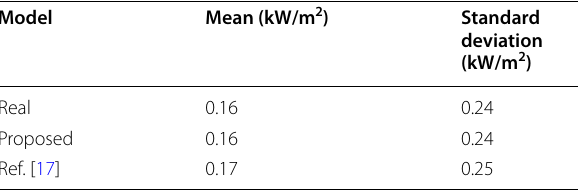
Table 5 Descriptive statistics for simulated